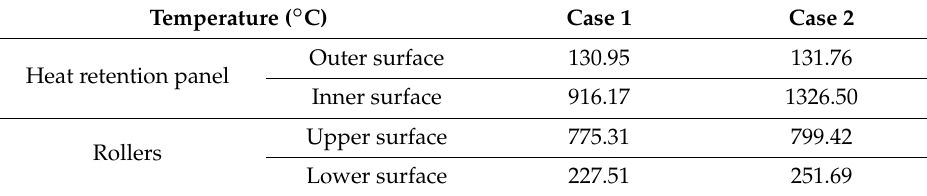
Table 5. Numerical data for different surfaces with the acting-type heat retention panel.